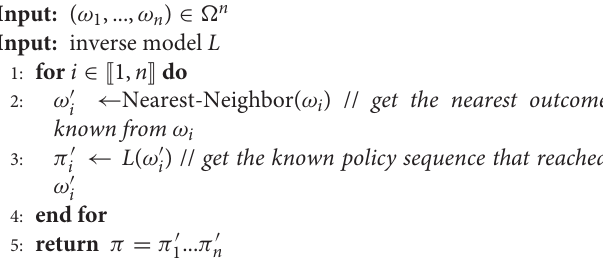
Algorithm 1 Procedure